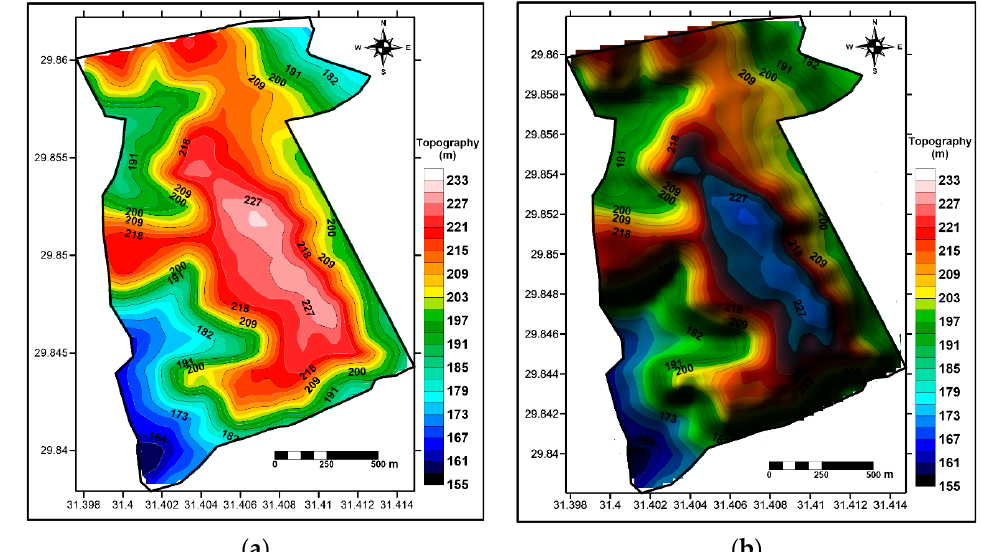
Figure 3. Topography of the study area: ( a ) 2D sheet and ( b ) 3D sheet.